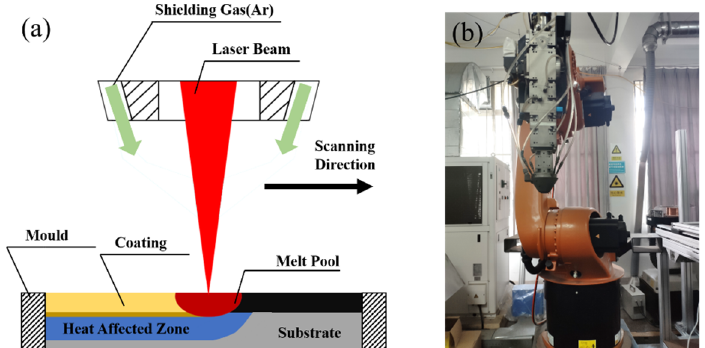
Figure 1. Diagram and appearance of laser cladding. ( a ) The laser cladding equipment and the pre- pared coating; ( b ) Afs-R6000 laser material processing system.